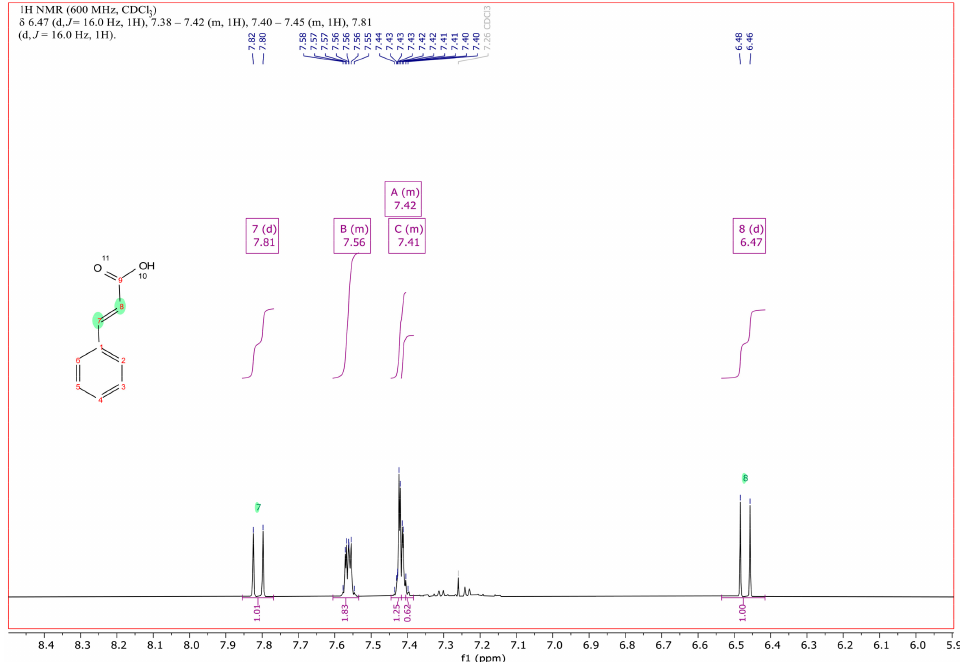
Figure 2. 1 H NMR spectrum of the double bond of the prop-2-enoic moiety of cinnamic acid at 6.47 and 7.81 ppm and of its aromatic protons from 7.41 to 7.56 ppm, recorded at 600 MHz in deuterochloroform. The minute signals around 7.3 ppm correspond to the aromatic protons of the biologically converted parent